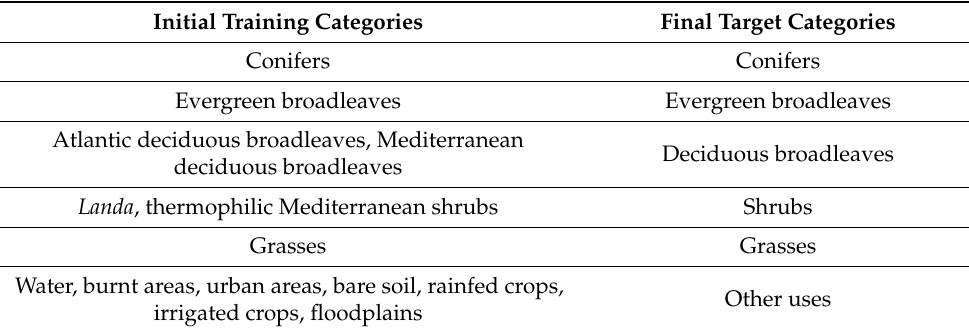
Table 1. Merger of